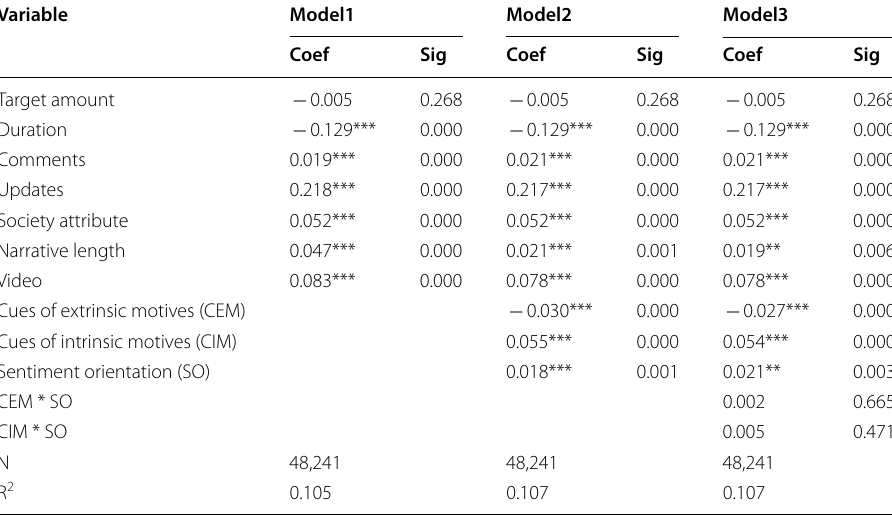
Table 9 Robust check of sentiment orientation